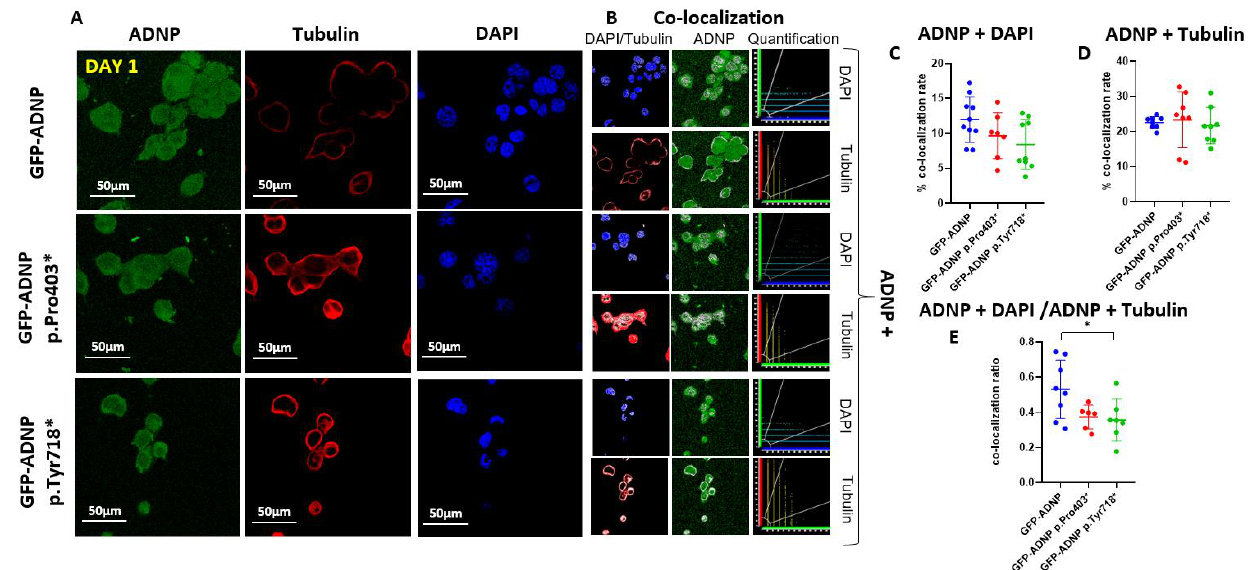
Figure 3. Immunostaining of tubulin and staining with DAPI after 24 h in culture revealed a minor effect of mutant protein expression. ( A ) Neuroblastoma cell lines expressing full-length ADNP or truncated ADNP proteins conjugated to GFP ( green ) were immunostained with monoclonal anti- tubulin ( red ) antibodies (TUB2.1), while cell nuclei were stained/visualized with DAPI (DNA, blue ). ( B ) Nuclear or cytoplasmic co-localization of the DAPI and ADNP or tubulin and ADNP, respectively, is represented by the white color (apparent dots); ×63 oil immersion lens. The quantification graphs show scatterplots of the white dots, depicting red (tubulin) or blue (DAPI) + green (ADNP) turned into white pixel intensities of the image shown in the adjacent pictures. ( C ) Quantitative analysis of ADNP – DAPI co-localization. ( D ) Quantitative analysis of ADNP-tubulin co-localization. ( E ) Quantitative analysis of ADNP – DAPI/ADNP-tubulin ratio of staining-based co-localization is represented, * p < 0.05. Nine fields were analyzed for each condition. A field is defined as one image by the confocal microscope (one image size = 1024 × 1024 pixels). Apparently, the majority of ADNP did not associate with microtubules or DNA (DAPI, D , E ), possibly reflecting the multiple protein interaction sites on the protein (Figure 1C).